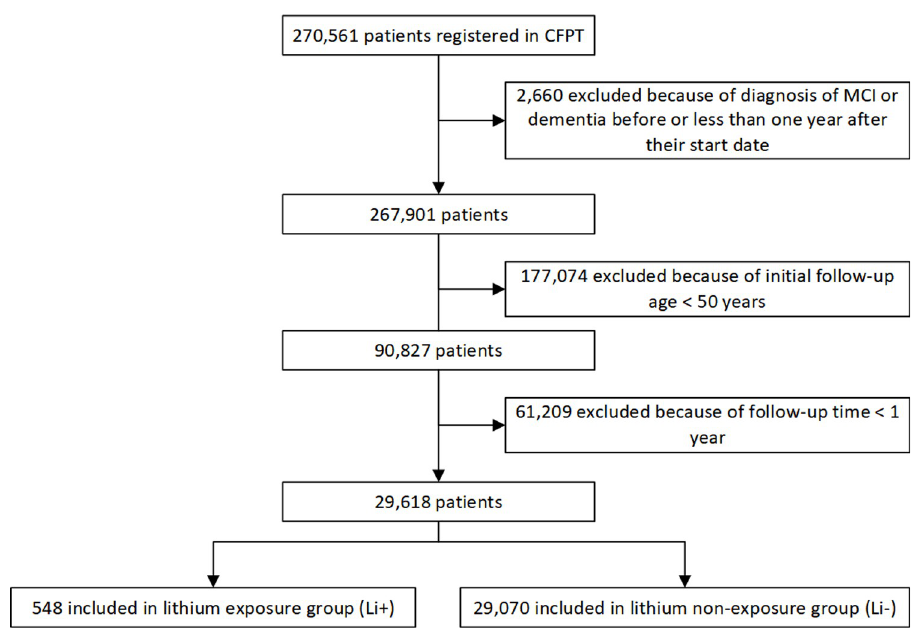
Fig 1. STROBE diagram showing construction of the cohorts. C AU : AbbreviationlistshavebeencompiledforthoseusedthroughoutFigs 1 (cid:0) 4 : Pleaseverifythatallentriesarecorrect : PFT, Cambridgeshire and Peterborough NHS Foundation Trust; MCI, mild cognitive impairment; STROBE, Strengthening the Reporting of Observational Studies in